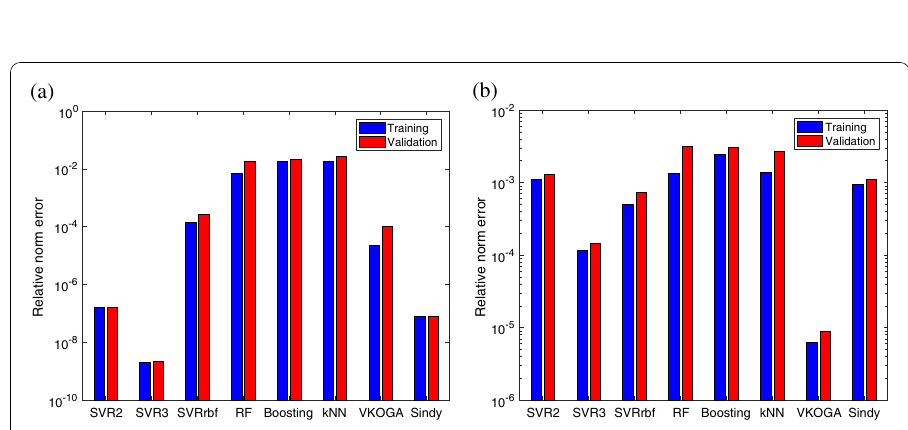
Fig. 13 Relative mean squared error vs. training size: a SVR2, (cid:11) = 10 − 4 , b SVR3, (cid:11) = 10 − 4 , c SVR rbf, (cid:11) = 10 − 4 , d random forest, e boosting, f kNN, g VKOGA. Note that the validation set is fixed, N Blue curves represent training errors and red curves represent validation errors